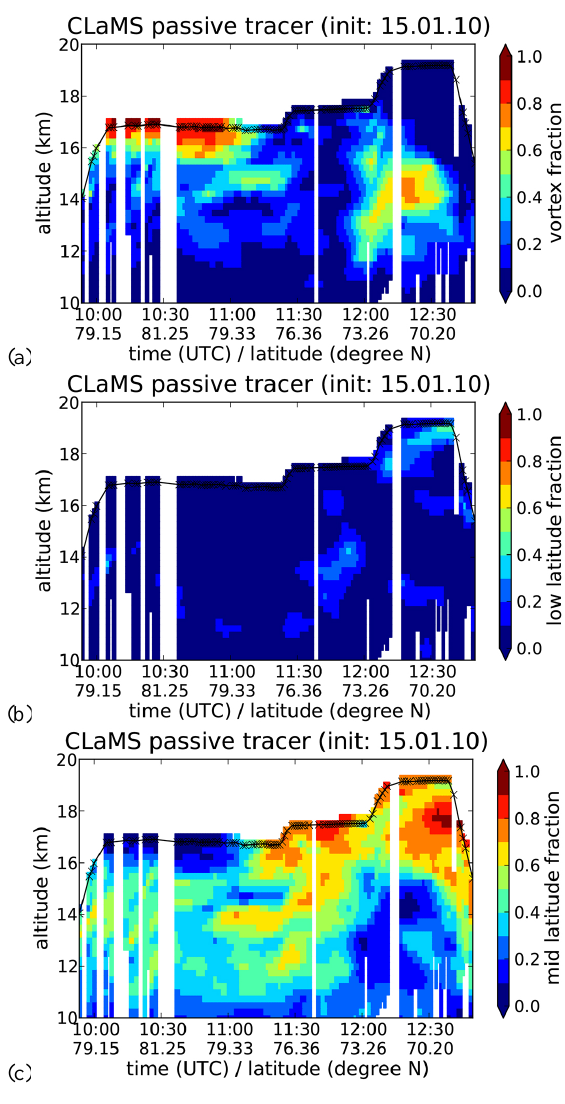
Fig. 6. Cross-sections of the CLaMS vortex tracer, low-latitude tracer, and mid-latitude tracer with initialisation on 15 January. For details see caption of Fig.